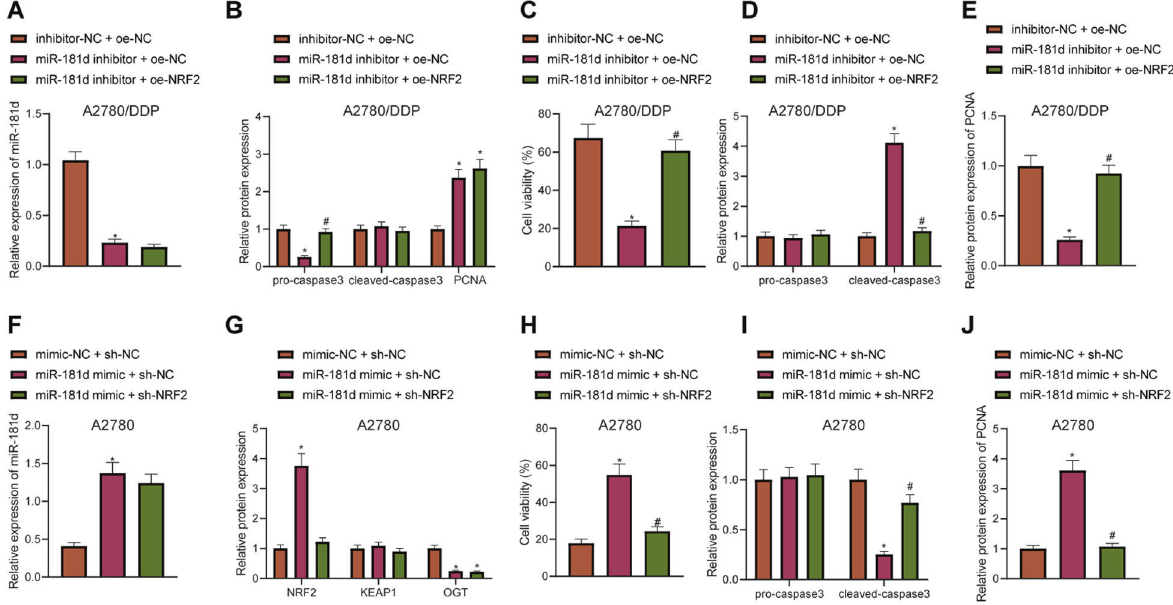
Fig. 6 miR-181d regulates DDP resistance of OC cells through the OGT/KEAP1/NRF2 axis. A2780/DDP cells were treated with inhibitor-NC + oe-NC, miR-181d inhibitor + oe-NC or miR-181d inhibitor + oe-NRF2. A RT-qPCR detection of miR-181d expression in A2780/DDP cells normalized to U6. B Western blot assay of OGT, KEAP1, and NRF2 expression and quantitative analysis in A2780/DDP cells normalized to β -actin. C CCK-8 assay of A2780/DDP cell viability. D Western blot assay of pro-caspase3 and cleaved caspase-3 expression and quantitative analysis in A2780/DDP cells normalized to β -actin. E Western blot assay of PCNA expression and quantitative analysis in A2780/DDP cells normalized to β -actin. A2780 cells were transfected with mimic-NC + sh-NC, miR-181d mimic + sh-NC or miR-181d mimic + sh-NRF2. F RT- qPCR detection of miR-181d expression in A2780 cells normalized to U6. G Western blot assay of the expression and quantitative analysis of OGT, KEAP1, and NRF2 in A2780 cells normalized to β -actin. H CCK-8 assay of A2780 cell viability. I Western blot assay of the pro-caspase3 and cleaved caspase-3 expression and quantitative analysis in A2780 cells normalized to β -actin. J Western blot assay of PCNA expression and quantitative analysis in A2780 cells normalized to β -actin. Cell experiments were repeated three times independently. * p < 0.05 versus A2780/ DDP cells treated with inhibitor-NC + oe-NC or A2780 cells treated with mimic-NC + sh-NC. # p < 0.05 versus A2780 cells treated with miR-181d mimic + sh-NC or A2780/DDP cells treated with miR-181d inhibitor +